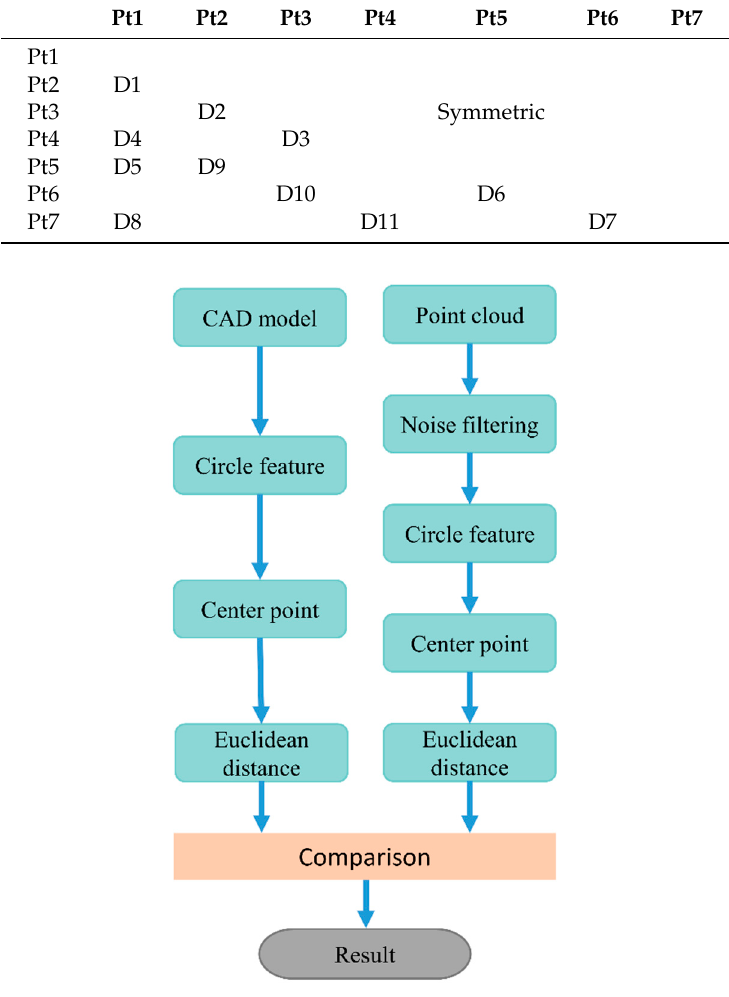
Figure 6. Work-flow of “feature distance” strategy.